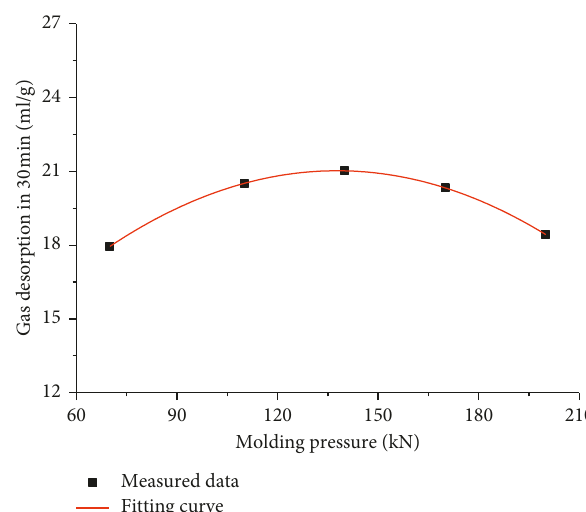
Figure 8: Curve of the gas desorption amount per unit mass in 30min versus the molding